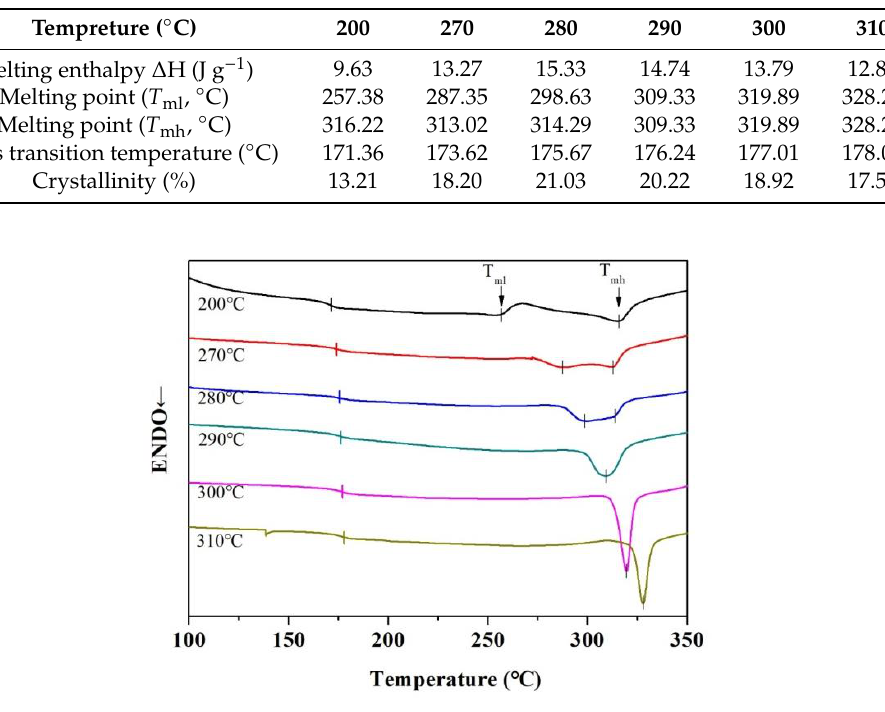
Figure 9. DSC curves of BT@ZnPc-GO-1/PEN films with 15 wt % BT@ZnPc-GO-1 after isothermal annealing at 200, 270, 280, 290, 300 and 310 °C for 2 h. Table 1. The physical parameter values of BT@ZnPc-GO-1/PEN films with 15 wt % BT@ZnPc-GO-1 after isothermal annealing at 200, 270, 280, 290, 300 and 310 °C for 2 h.